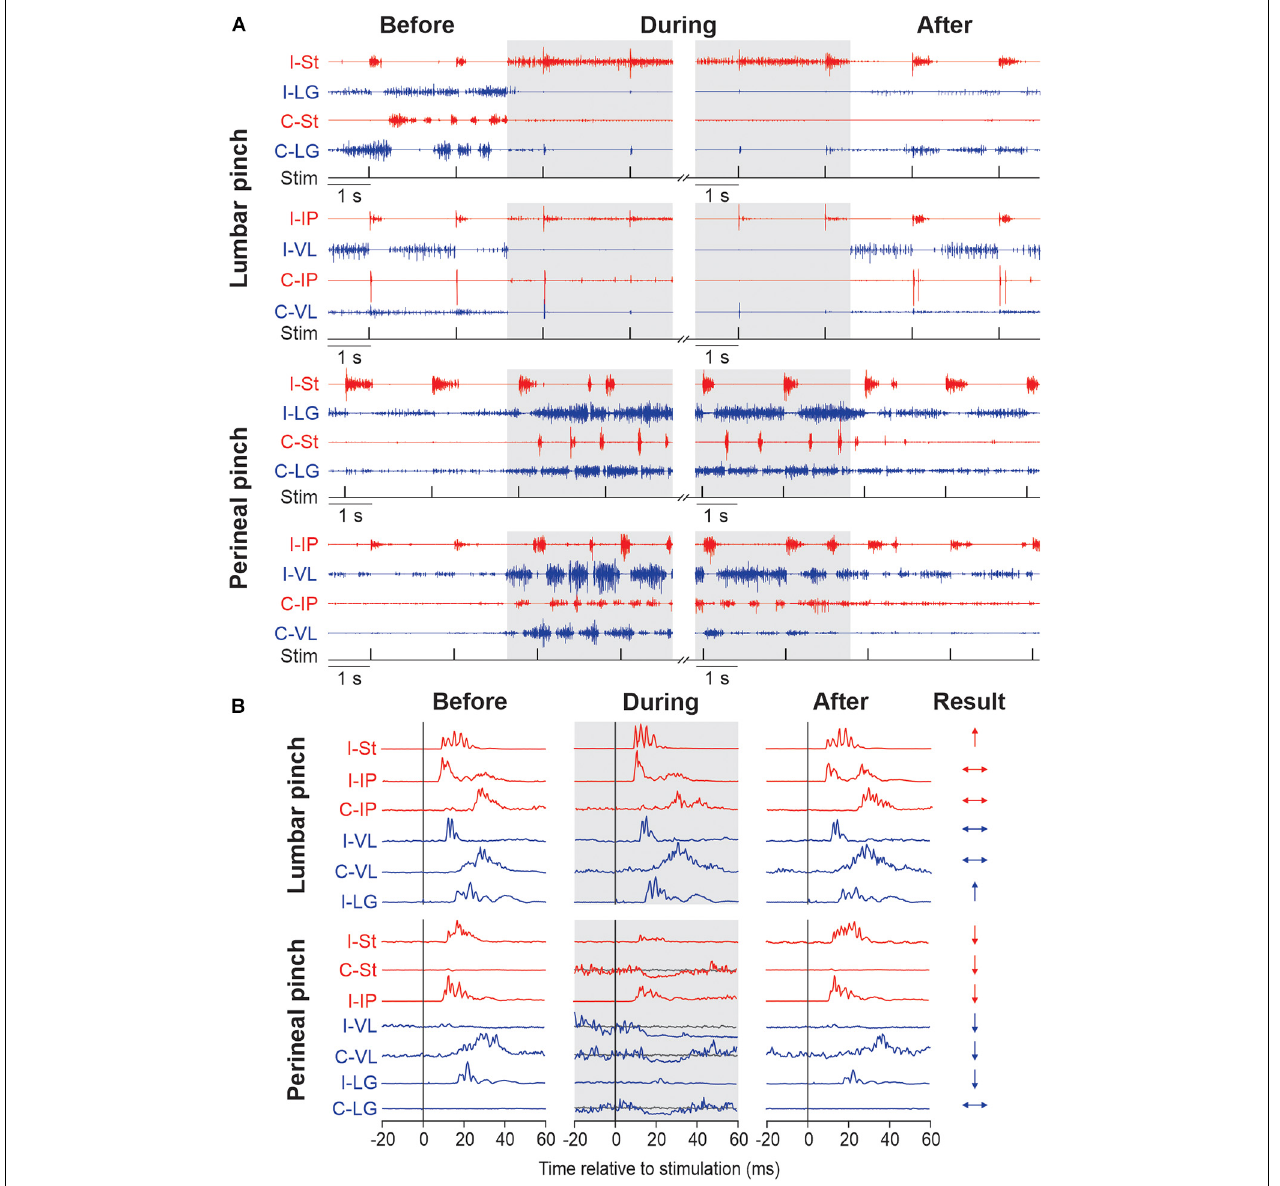
FIGURE 1 | Modulation of hindlimb muscle activity and electrically evoked cutaneous reflexes when pinching the lumbar or perineal skin. (A) Each panel shows the electromyography (EMG) activity from the ipsilateral (I) and contralateral (C) semitendinosus (St, blue), lateralis gastrocnemius (LG, red), iliopsoas (IP, blue) and vastus lateralis (VL, red) while stimulating the superficial peroneal nerve before, during (in gray) and after pinch of the lumbar and perineal regions. The timing of the stimulation (Stim) is shown below the EMGs. Panels are from two representative cats. (B) Short-latency ipsilateral and contralateral reflex responses evoked by stimulating the superficial peroneal (SP) are shown for each period of the trial in selected hindlimb muscles. Waveforms are averages of 13–15 stimulations per period for a representative cat in an 80 ms window. To better visualize short-latency inhibitory responses, we superimposed averaged traces that received a stimulation (line in blue or red) with averaged traces without stimulation (line in gray). On the right, the results of reflex responses modulation of selected muscles with lumbar or perineal pinch are illustrated ( ↑ , significant increase; ↓ , significant decrease; ↔ , non-significant difference in reflex responses). The figure is modified and reproduced with permission from Merlet et al. (2020,